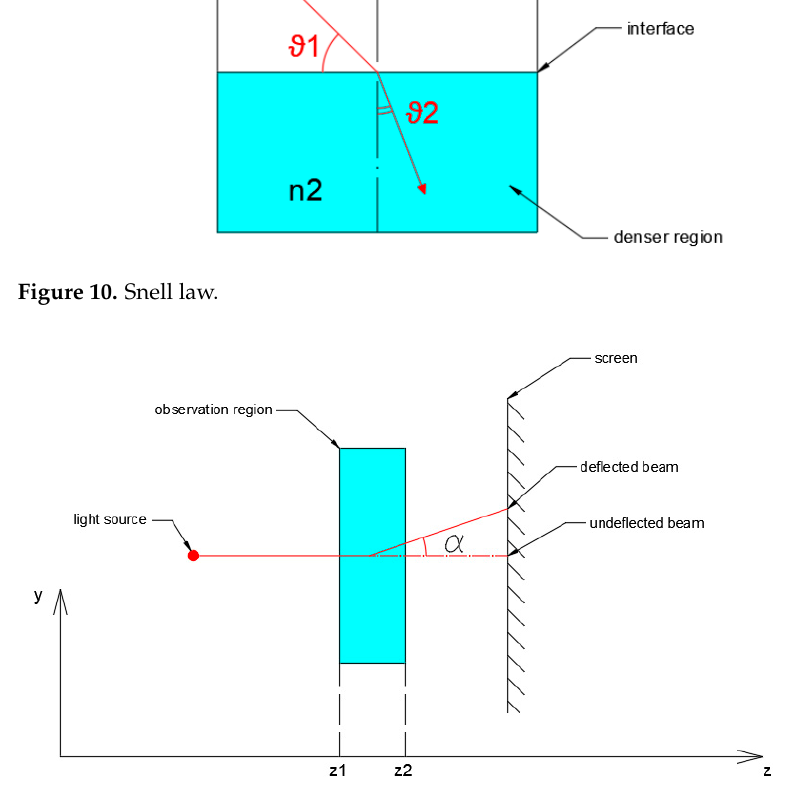
Figure 11. Shadowgraph principle.